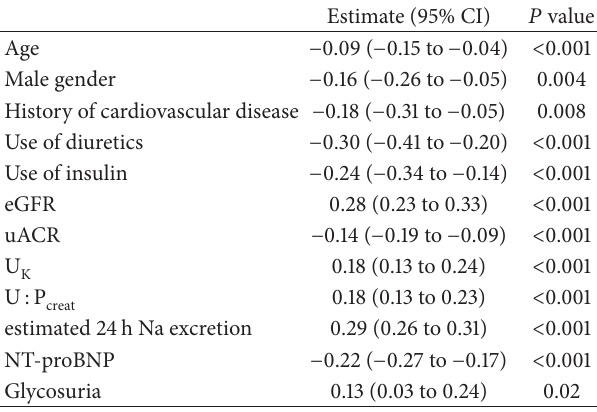
Table 2: Association of clinical and biological characteristic vari- ables with measured urinary sodium concentration (Spearman’s